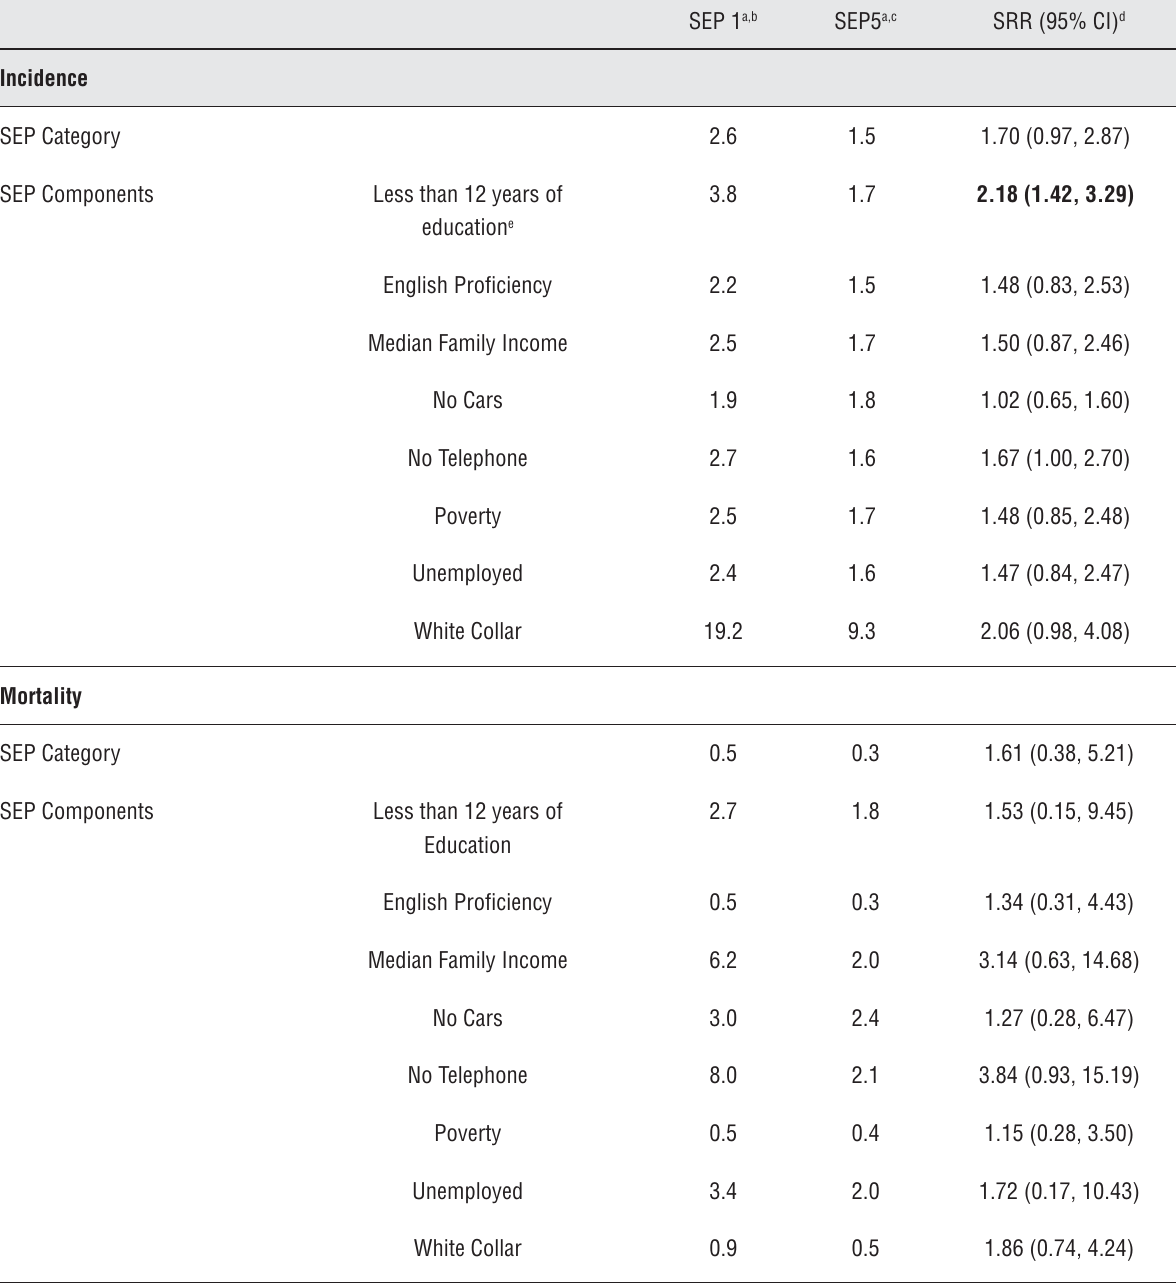
Table 3 - Age-standardized (x100,000) incidence and mortality rates for Penile Cancer by SEP index: Puerto Rico